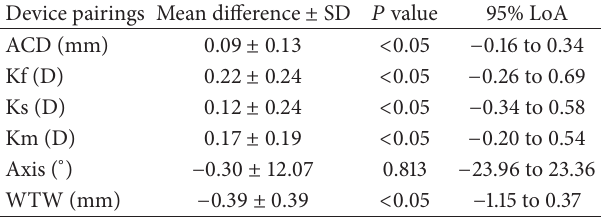
Table 2: The mean difference, limits of agreement (LoA), paired 𝑡 -test for these differences, and their significance for difference parameters between Sirius Scheimpflug/Placido photography-based topography system and IOLMaster partial coherence interferome- try.